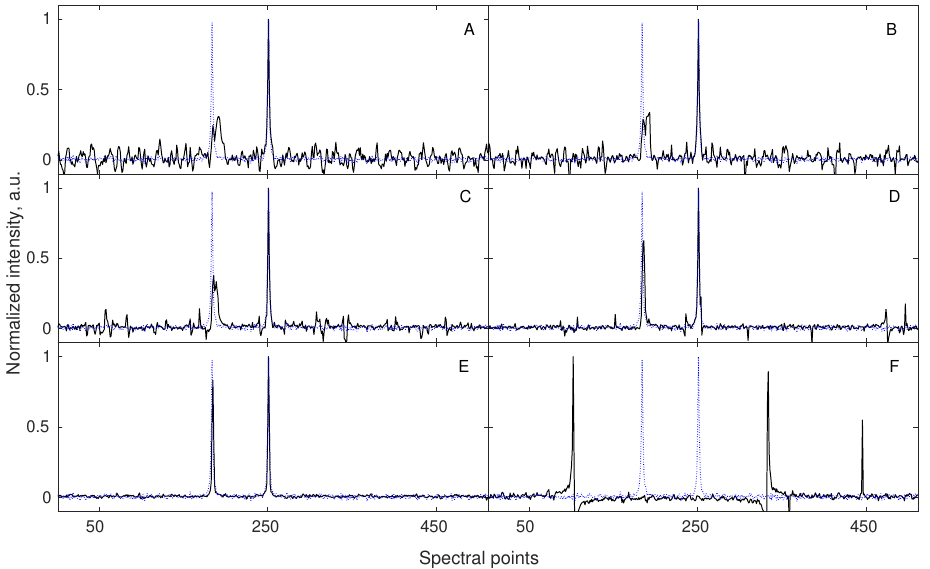
Figure 5. A simulation showing the benefit of applying NUS for the acquisition of a non-stationary signal (with frequency varying linearly during the experiment). A signal of 512 points length contains two components of equal amplitudes (blue dotted line in each subplot). The frequency of the component corresponding to the left peak changes by 0.05 spectral point with every NUS point acquired. The sampling levels and total frequency change are: 100% and 25.6 pts. ( A ), 75% and 19.2 pts. ( B ), 50% and 12.8 pts. ( C ), 25% and 6.4 pts. ( D ), 12.5% and 3.2 pts. ( E ), and 6.25% and 1.6 pts. ( F ). The sampling schedule is shuffled so the change is not linear in a sampled time, but in